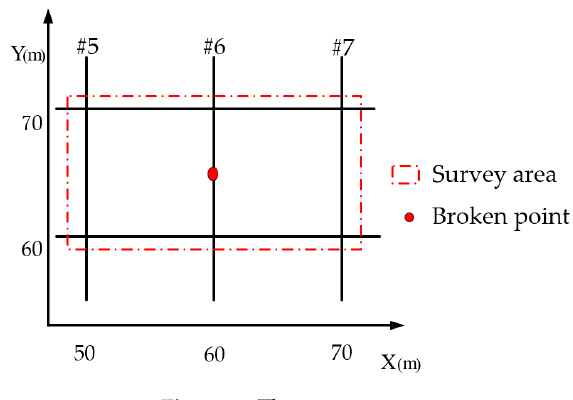
Figure 6. The survey area.